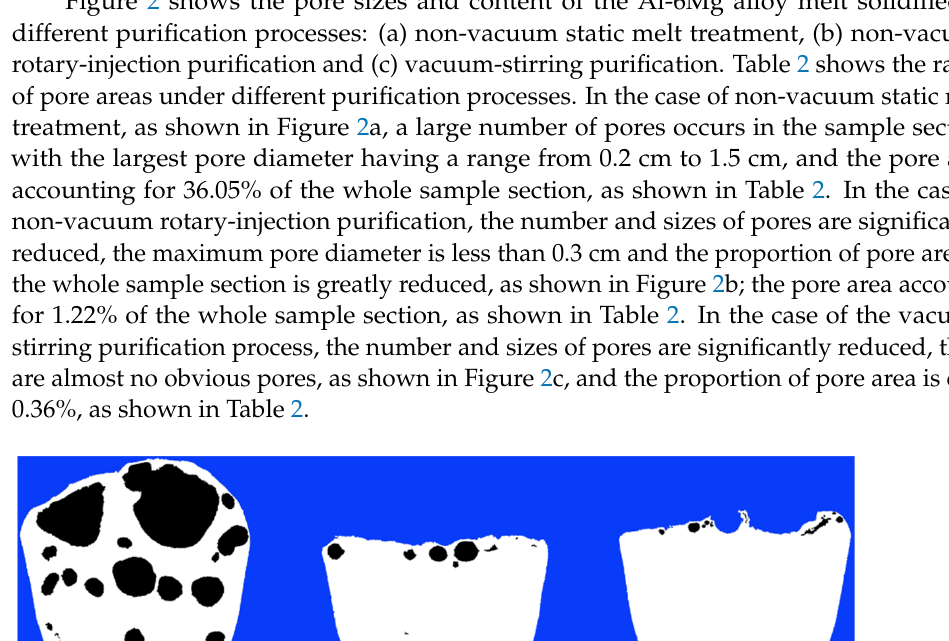
Figure 1. The schematic view of the purification process of Al-6Mg alloy.